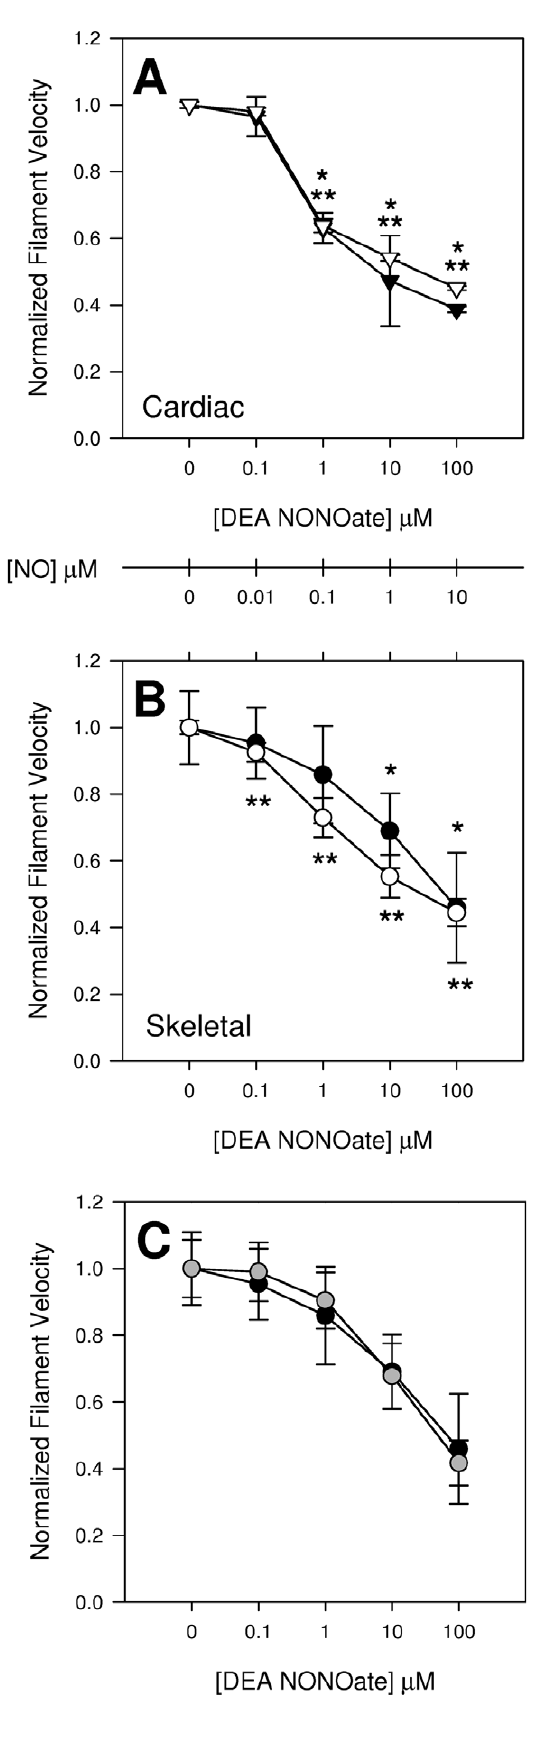
Figure 1. Dose-response and PO 2 interactions of the NO donor DEA NONOate on myosin. A: Cardiac myosin at high (open symbols, 20%, 152 mmHg) and physiologic (solid symbols, 2%, 15 mmHg) PO 2 . PO 2 has no significant effect on the response of isolated cardiac myosin to the NONOate. B: Same as A, but with skeletal muscle myosin